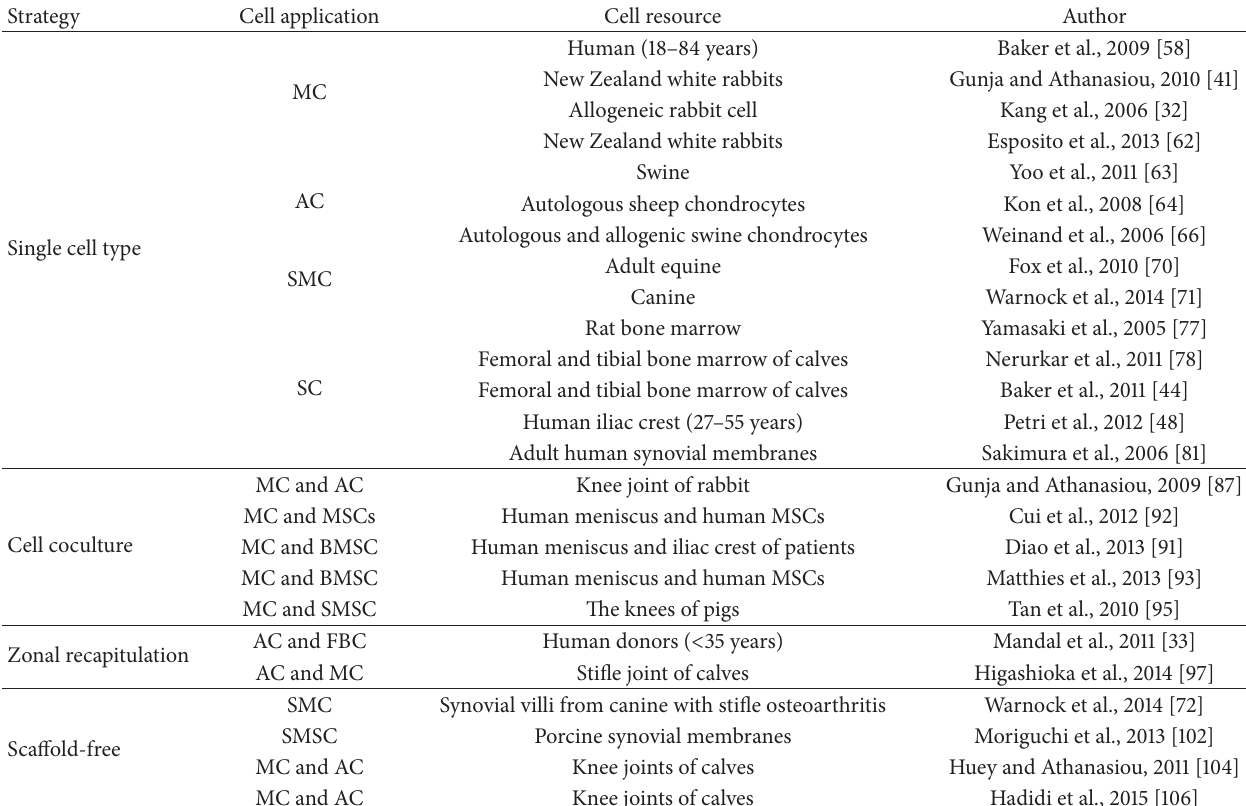
Table 1: Cell application in meniscus tissue